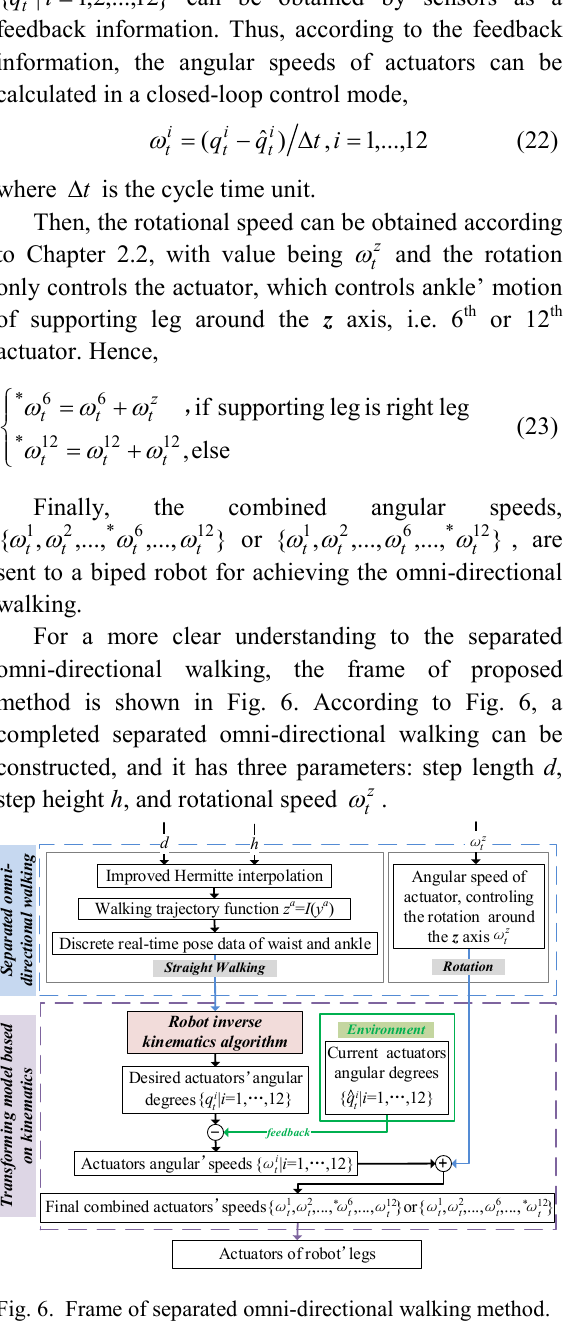
Fig. 6. Frame of separated omni-directional walking